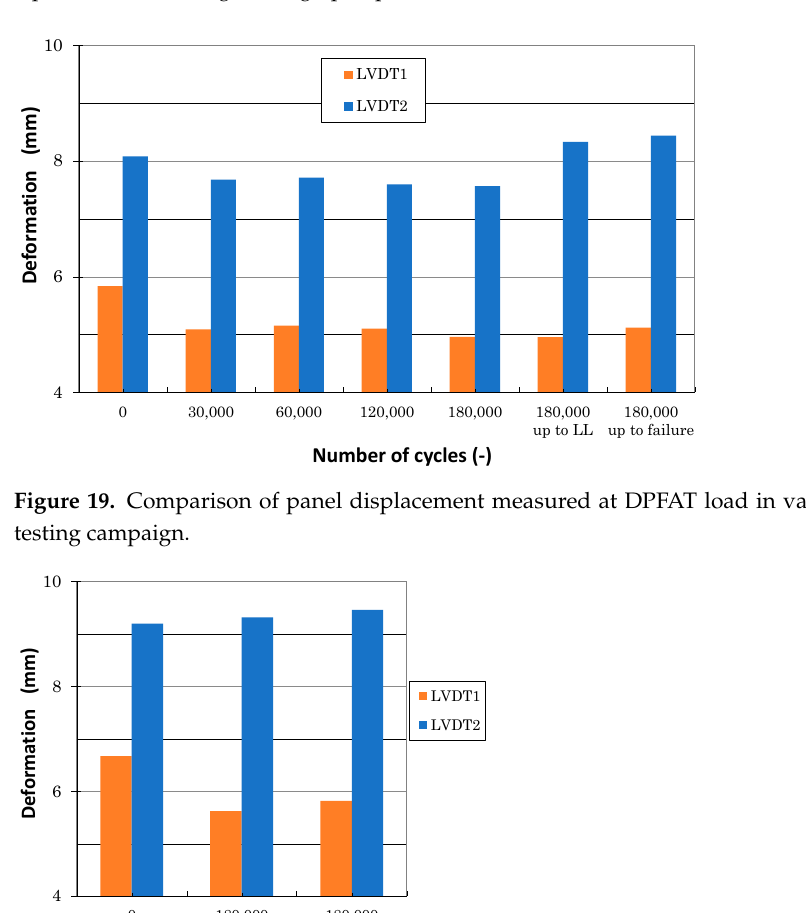
Figure 18. Comparison of panel deformation measured using LVDT sensors at various stages of the fatigue test (( a ) loading up to DPFAT and LL, ( b ) complete data including loading up to panel failure).